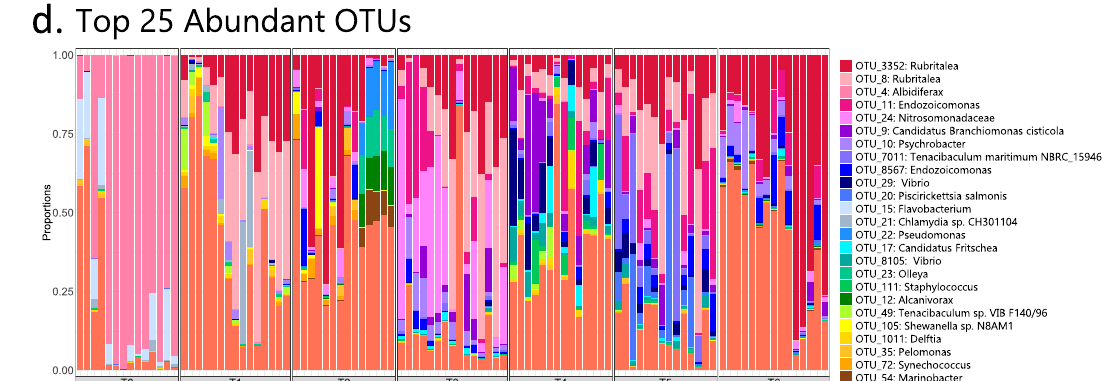
Figure 4. Microbial diversity and community structure from temporal gill analyses. ( a – c ) represent alpha diversity, environmental filtering, and beta diversity indices, respectively. In ( a ) and ( b ), the regions have been shaded using LOESS smoothing in geom_smooth() when plotting using R’sggplot(). In ( c ), ellipses are drawn at 95% confidence interval of standard error with lines from T0 to T6 plotted at the mean of the ordination values at each timepoint. ( d ) shows community structure based on relative abundance of the top 25 most abundant OTUs from across each timepoint, where ‘others’ refers to all OTUs not included in the top 25; lines for figures ( a ) and ( b ) connect two categories where the differences were significant (ANOVA) with *( P < 0.05), **( P < 0.01), or ***( P < 0.001). Figure titles with *** refer to analyses that included significant